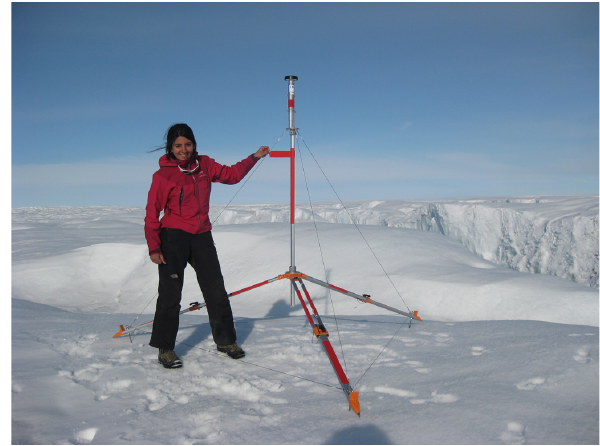
Figure 2. Deployment of a GPS instrument on